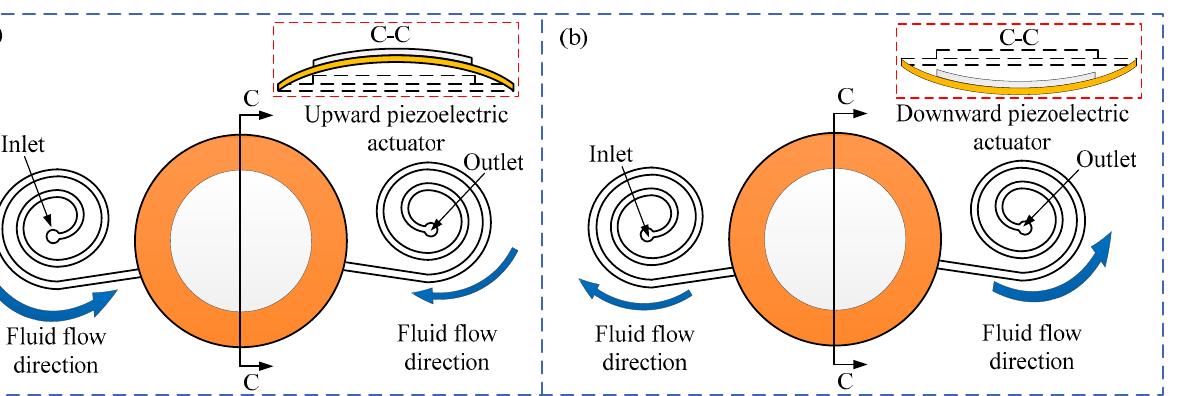
Table 2. Summary of properties for the valveless piezoelectric pump with Y-shape tubes. First Author and Year